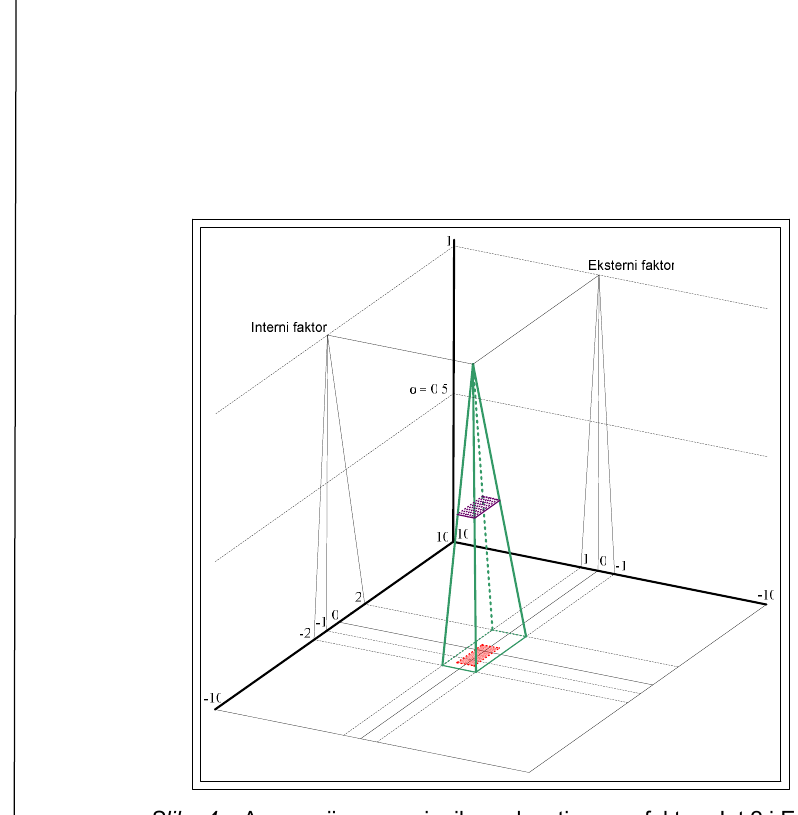
Figure 4 – Estimated value aggregation for the pair of factors Int 2 and Ext 6 Postupak ekstrahovanja strategijskih opcija, na osnovu rezultata agregacije, svodi se na izbor α preseka (0 ≤ α ≥ 1 ) formiranih piramida, njegovu projekciju na ravan baza piramida i utvr đ ivanje udaljenosti tih projekcija od temenih ta č aka SWOT matrice u osnovi. Naj č eš ć e se za α presek uzima vrednost α = 0,5, dok se za kriterijum, na osnovu kojeg ć e se utvr đ ivati udaljenost projekcija od temena matrice, preporu č uje izbor jednog od slede ć